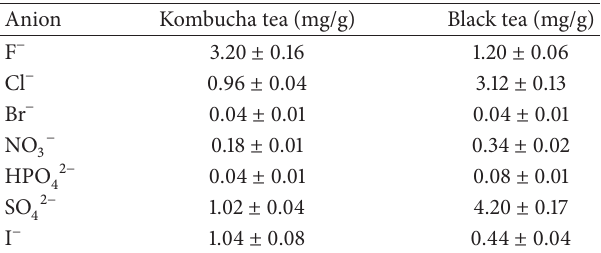
value of this beverage has a buffering capacity. This buffering Table 1: Comparison of anionic mineral concentration of Kom- bucha tea and Black tea